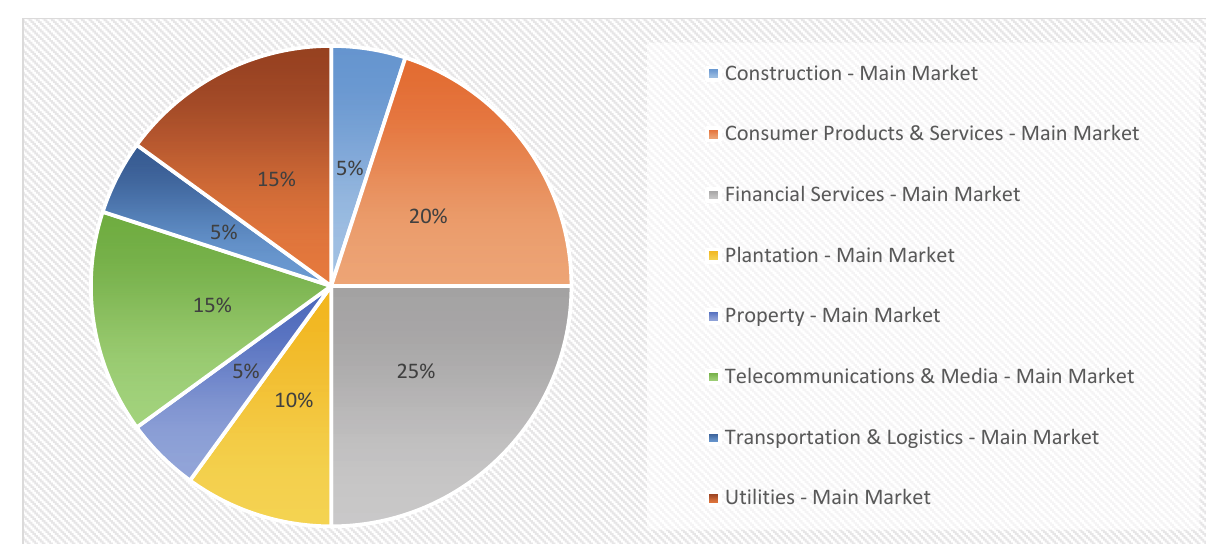
Fig. 3. Bottom rating portfolio constituents (Industry)